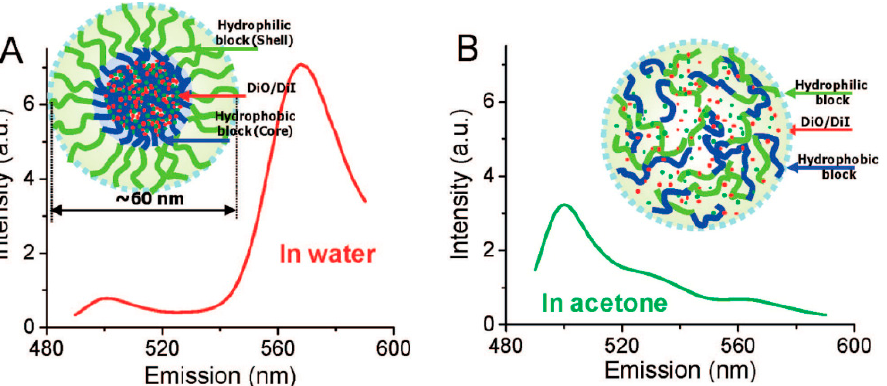
Figure 11. Fluorescence spectra of PEG-PDLLA FRET micelles diluted 10 times with water ( A ) and 10 times with acetone ( B ). Reproduced with permission from ref. [31]. Copyright 2008, American Chemical Society.